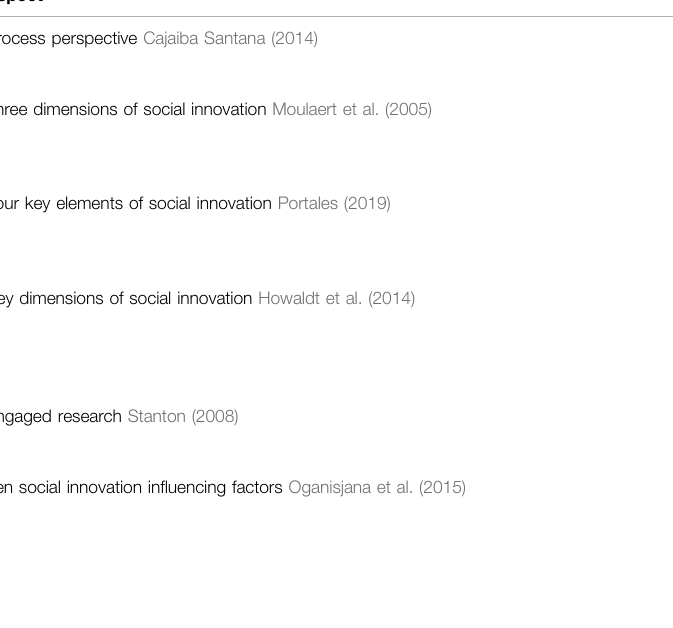
TABLE 1 | List of social innovation aspects (non-exhaustive).